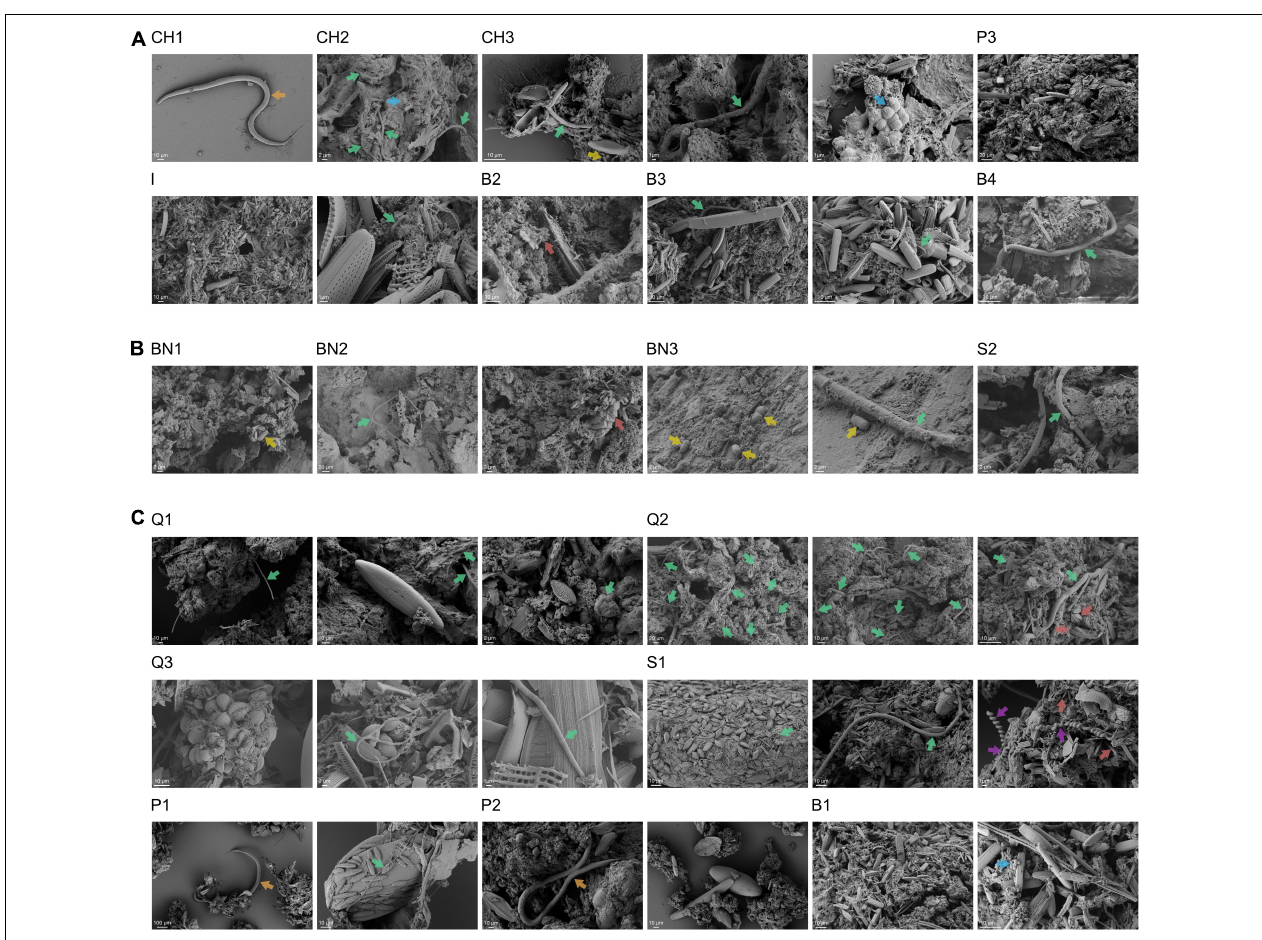
FIGURE 4 | Diatoms, filamentous cyanobacteria and other prokaryotic cells form nano-globular carbonate aggregates in most of the AMEs. (A) SEM images of the microbialites. CH1, CH2 and CH3, Microbialites from Laguna Chaxa; P3, Microbialite from Laguna La Punta; I, Microbialite from Laguna Interna; B2, B3 and B4, Microbialites from Laguna Brava. (B) SEM images of the endolithic microbial communities. BN1, BN2 and BN3, Endoevaporites from Laguna Barros Negros; S2, Microbial community within an Andean flamingo mound nest from Laguna Salada. (C) SEM images of the microbial mats and the pink/orange sediment. Q1 and Q2, Microbial mats from Aguas de Quelana; Q3, Sediment-associated microbial community from Aguas de Quelana; S1, Microbial mat from Laguna Salada; P1 and P2, Microbial mats from Laguna La Punta; B1, Microbial mat from Laguna Brava. Different recognized structures are marked with an arrow. Green arrow, Filamentous cyanobacterium; Blue arrow, Coccus; Yellow arrow, Bacillus; Purple arrow, Spirochete; Orange arrow, Nematode; Red arrow, Mineral